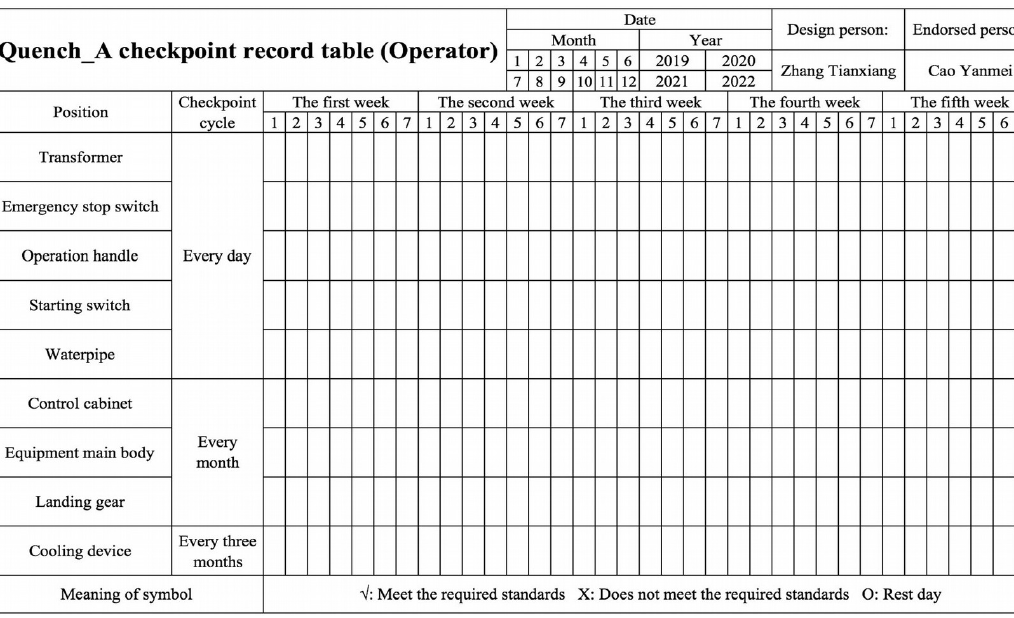
Figure 11. The checkpoint record for Quench_A (The actual display is in